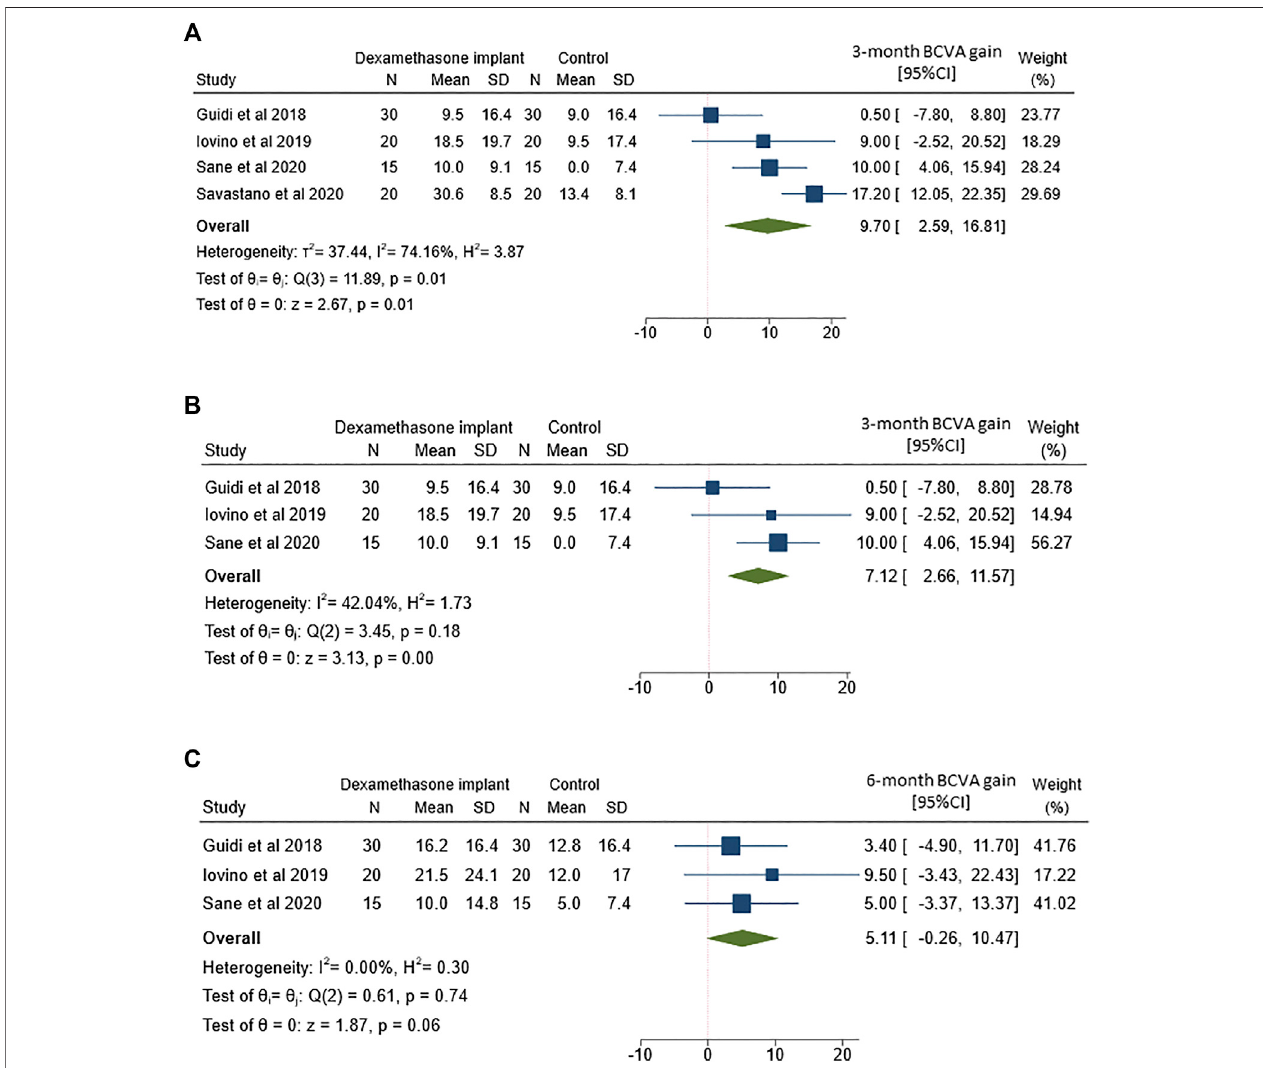
FIGURE 2 | Forest plots of the comparison of mean best corrected visual acuity (BCVA) gain between vitrectomy with and without intravitreal dexamethasone implant (A) BCVA gainassessed at 3-months follow-up (B) Sensitivity analysisofBCVA gainat3-monthsfollow-upbyexcludingthestudy bySavastano and coworkers (C) BCVA gain assessed at 6-months